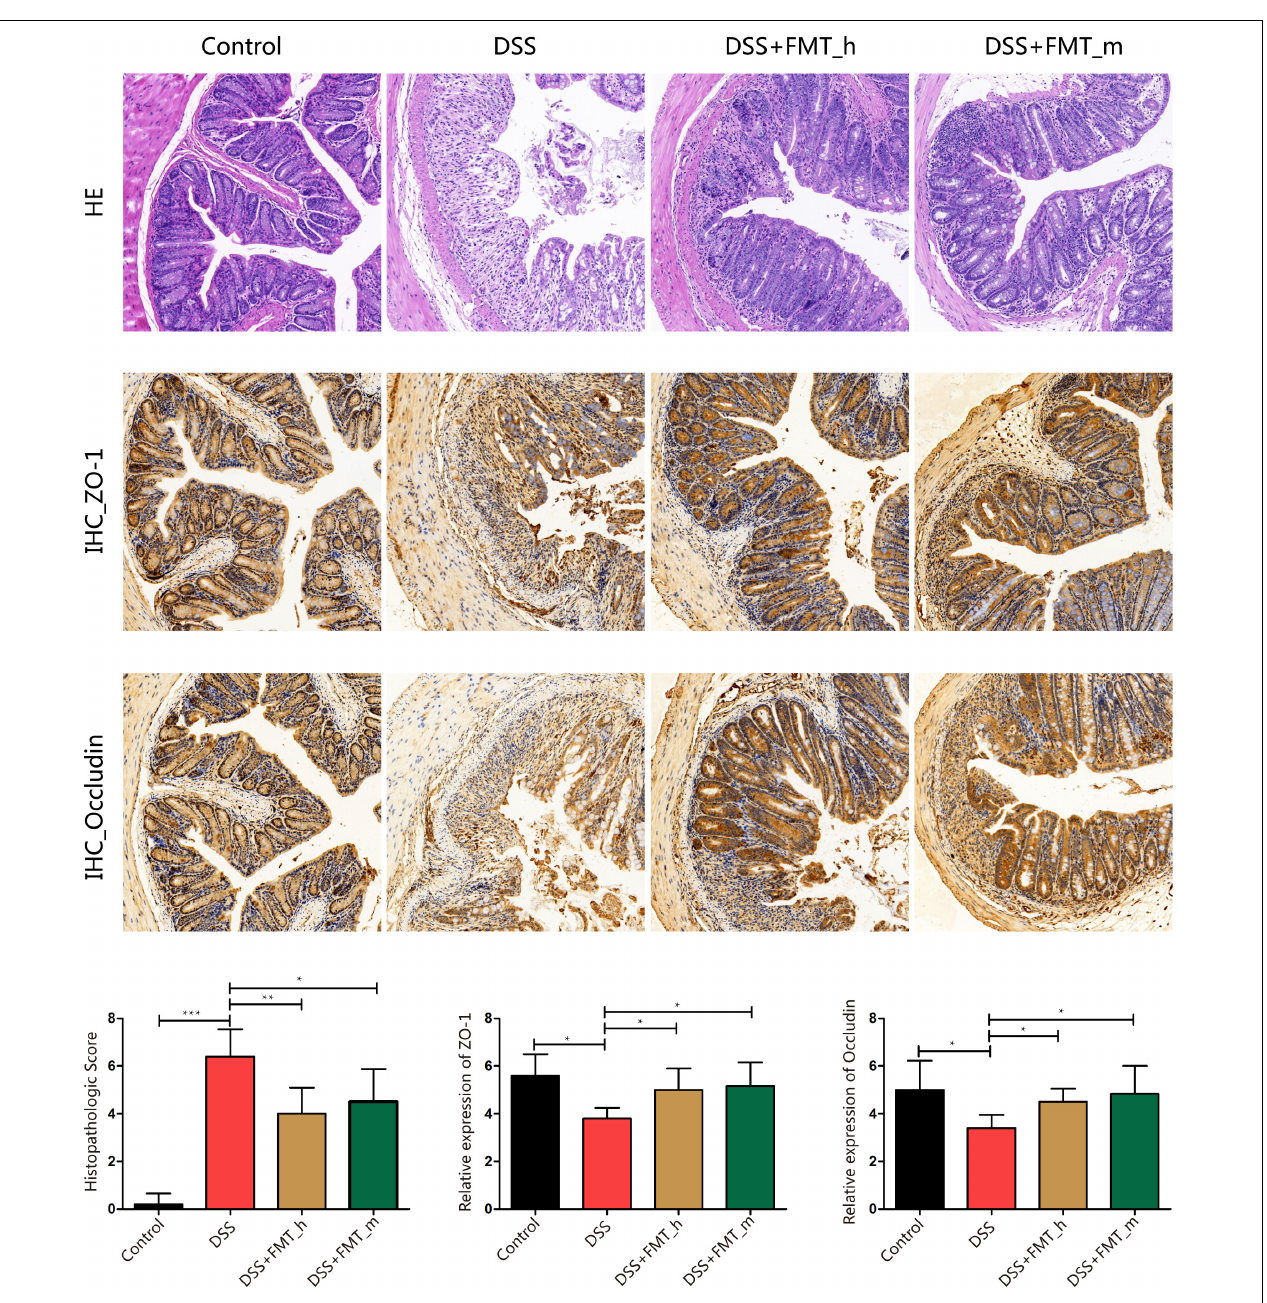
FIGURE 2 | FMT mitigates the pathological changes in the colonic epithelium and rescues ZO-1 and occludin expression in the colon tissues of colitis mice. At the end of the experiment, the colonic tissues were dissected and stained with H&E or immunohistochemistry using anti-ZO-1 or anti-occludin. Data are representative images (magnification × 200) or expressed as mean ± SD of each group ( n = 5–6) from three separate experiments. The bottom row displays colon histopathological score, relative ZO-1, and occludin expression in the colonic tissues of each group of mice. * p < 0.05, ** p < 0.01, *** p <